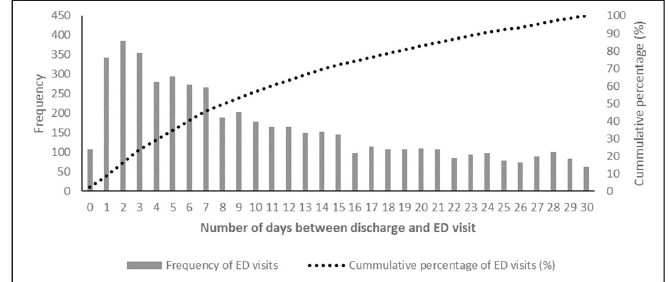
Fig 1. Distribution of ED visits per number of days between discharge and ED visit. Notes: ED–emergency